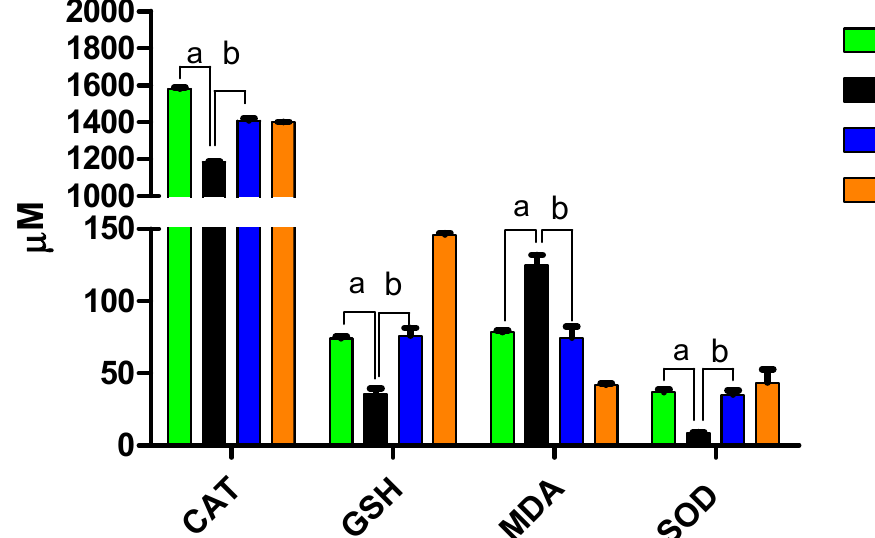
Figure 1. Noscapine prevented rotenone-induced oxidative stress and enhanced antioxidant enzymes in rats. Administration of rotenone increased ( p < 0.05) lipid peroxidation, which is represented by increase in malonaldehyde levels with significant reduction in vital antioxidant levels in the midbrain ( n = 5). However, treatment with noscapine prevented lipid peroxidation with a significant decrease in MDA levels and reverted brains’ vital antioxidant (CAT, GSH and SOD) levels. Data are expressed as mean ± SEM. a p < 0.05 compared to control, b p < 0.05 compared to rotenone-treated group.